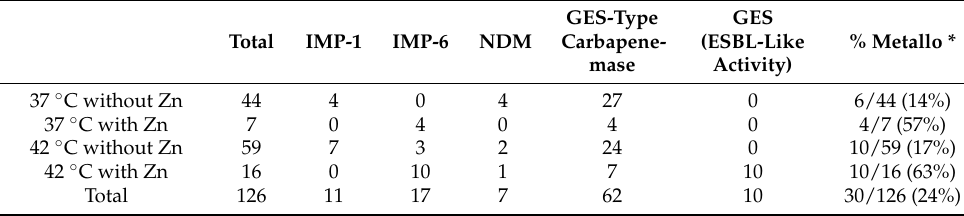
Table 4. Results of carbapenemase genes carried by Enterobacterales with different isolation conditions.